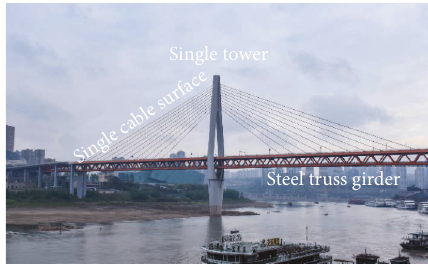
Figure 1: A steel truss cable-stayed bridge with a single tower and a single cable plane (m).